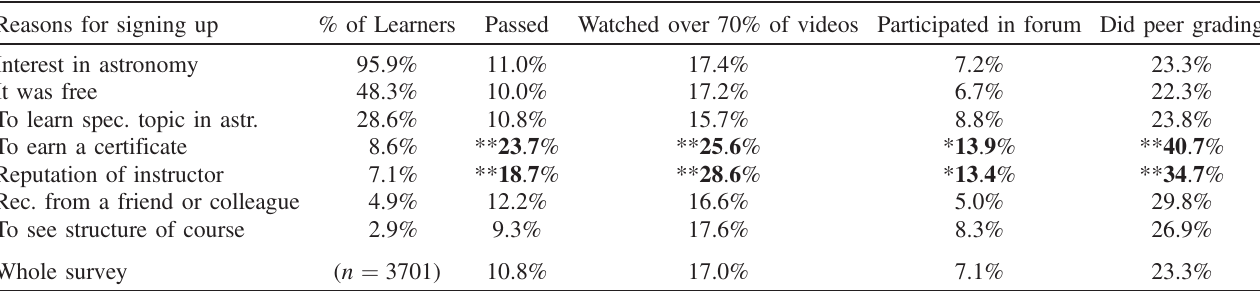
TABLE III. Answers to the question: “ Why did you sign up for the course? ” and the engagement scores. Each group was compared with the rest of the people in the survey using a two sample KS test. Statistically significant results at p ¼ 0 . 05 (*) and p ¼ 0 . 01 (**) level are in bold